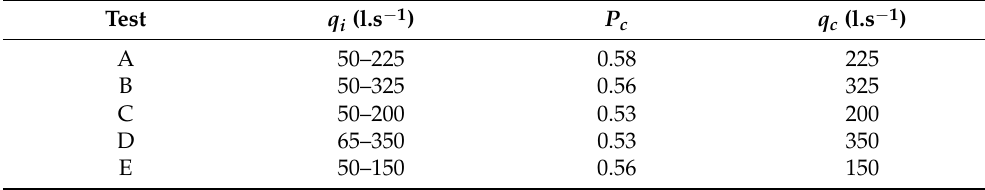
Table 1. Discharge range, critical discharge, and packing factor values for each of the five tests.